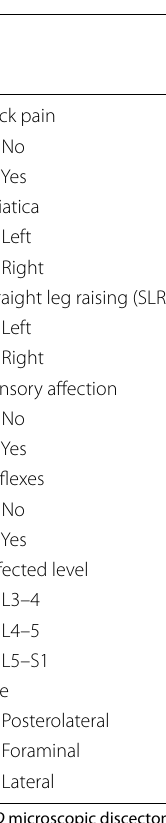
Table 2 Comparison between the 2 study groups as regard clinical data